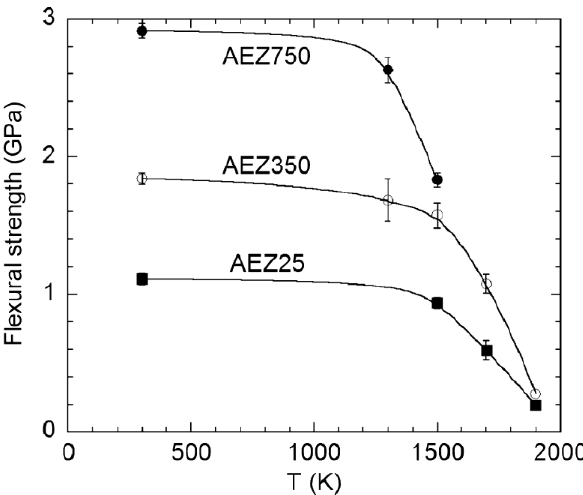
Figure 13. Flexural strengths of AEZ25 (25 mm/h), AEZ350 (350 mm/h) and AEZ750 (750 mm/h) as a function of temperature. Reproduced with permission from Reference [47], Copyright © 2018 Elsevier Ltd.